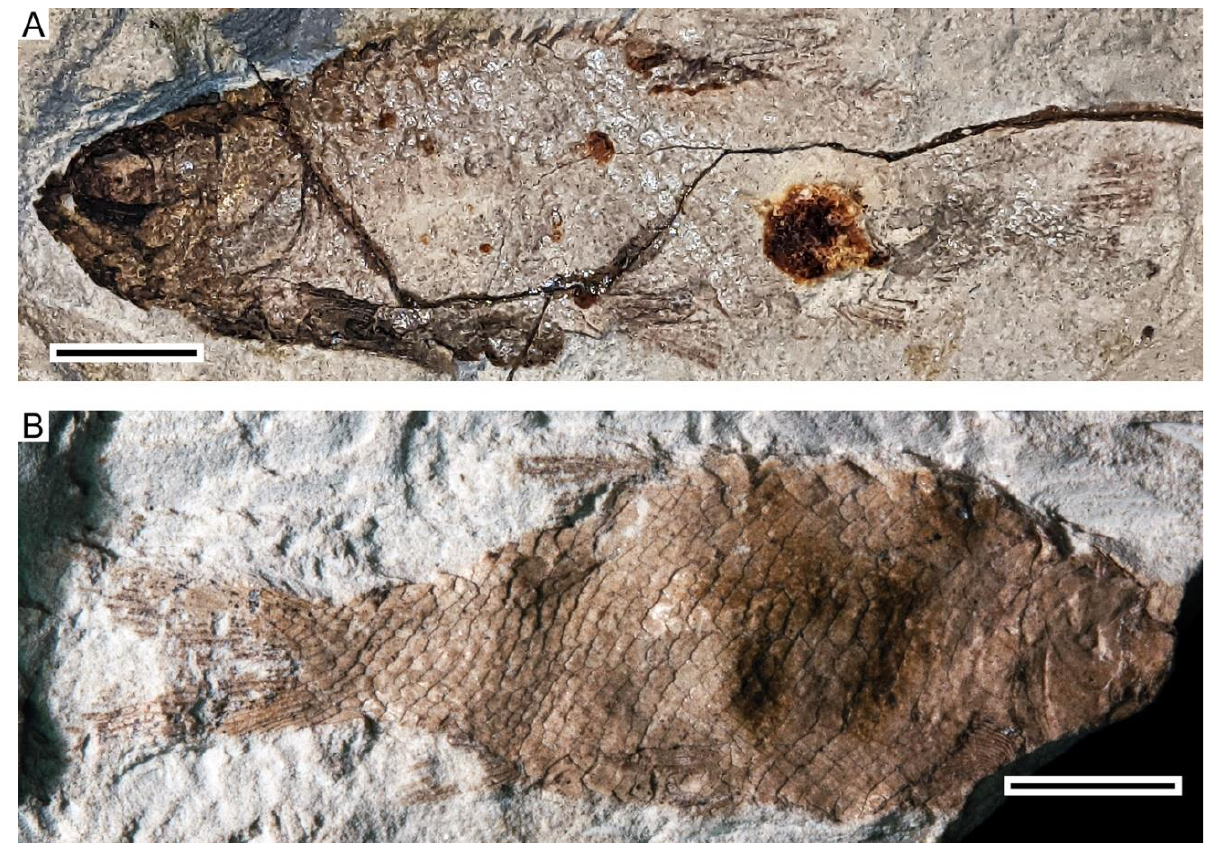
Diversity 2022 , 14 , x FOR PEER REVIEW 6 of 21 Figure 1. Seinstedtia parva gen. et sp. nov., from horizon MFL, Section F1, Fuchsberg Quarry near Seinstedt, Lower Saxony, upper Norian, Upper Triassic. ( A ) holotype MLU Sei.2010.76 in lateral view; ( B ) paratype MLU Sei.2010.36 in lateral view. Scale bars = 5 mm. Photograph, courtesy of John Chorn.